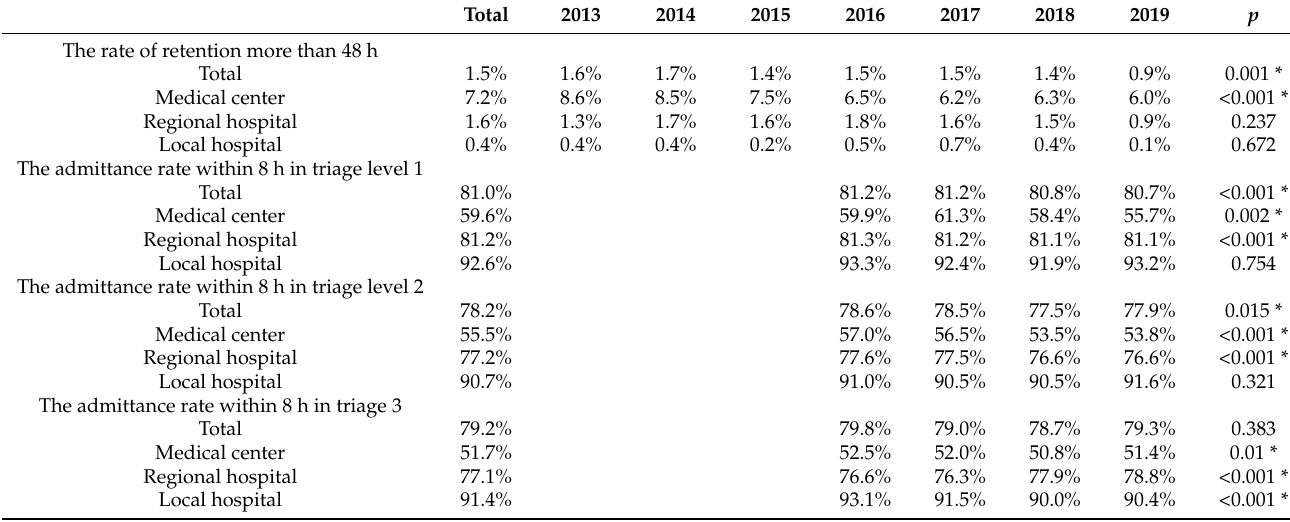
Table 3. Rate of retention more than 48 h in emergency department from different hospital